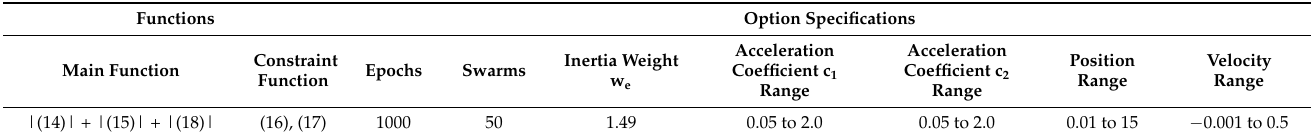
Table 4. The function parameters of the particle swarm optimization algorithm.